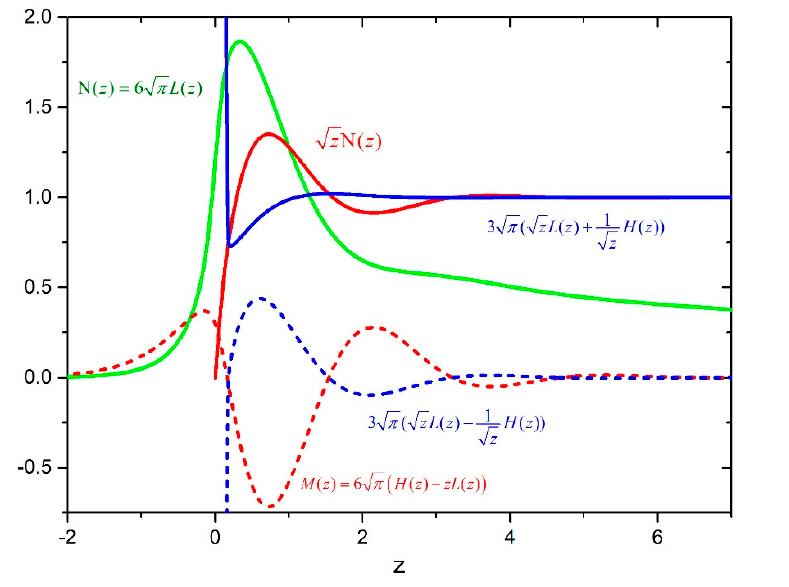
√ √ √ z N ( z ) , 3 π ( ζ L ( z ) + 1 √